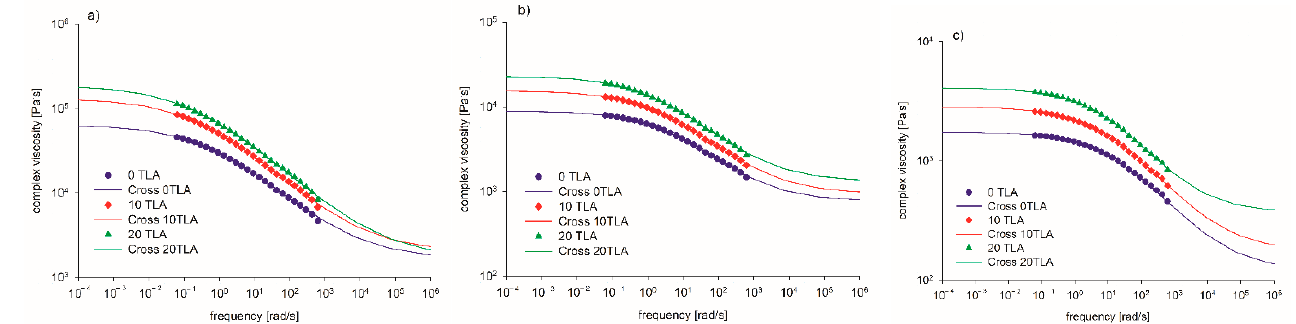
Figure 9. Measured and calculated viscosities versus angular frequency on a log-log plot at ( a ) 40 °C; ( b ) 50 °C; ( c ) 60 °C.